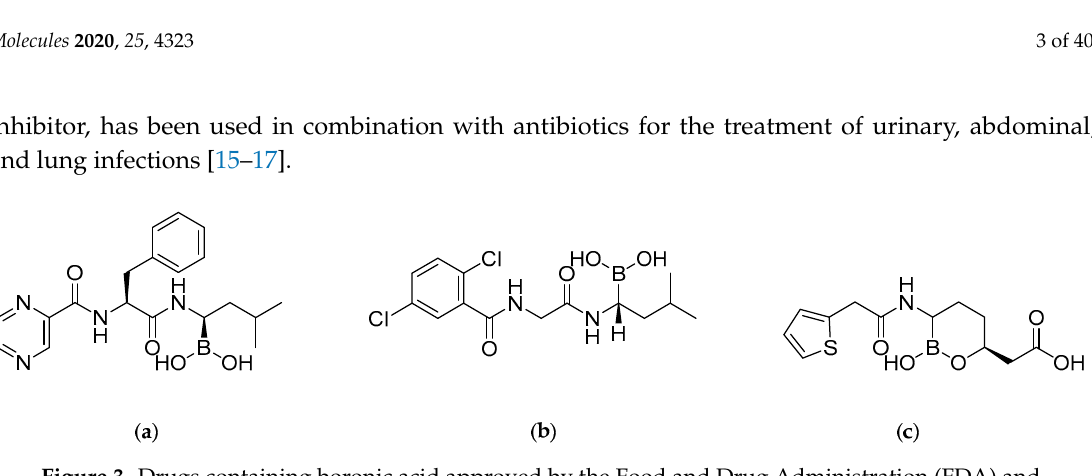
Figure 3. Drugs containing boronic acid approved by the Food and Drug Administration (FDA) and the European Medicines Agency (EMA). ( a ) Bortezomib. ( b ) Ixazomib. ( c ) Vaborbactam.